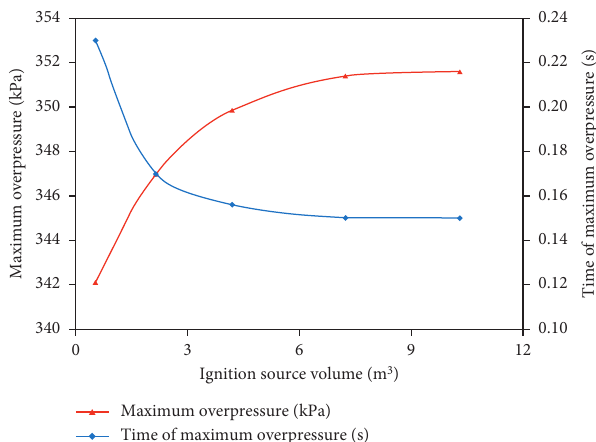
Figure 6: Relationship of the overpressure and peak time with the ignition source.